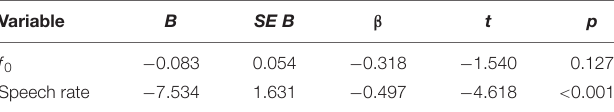
TABLE 4 | Predicting estimated age from f 0 and speech